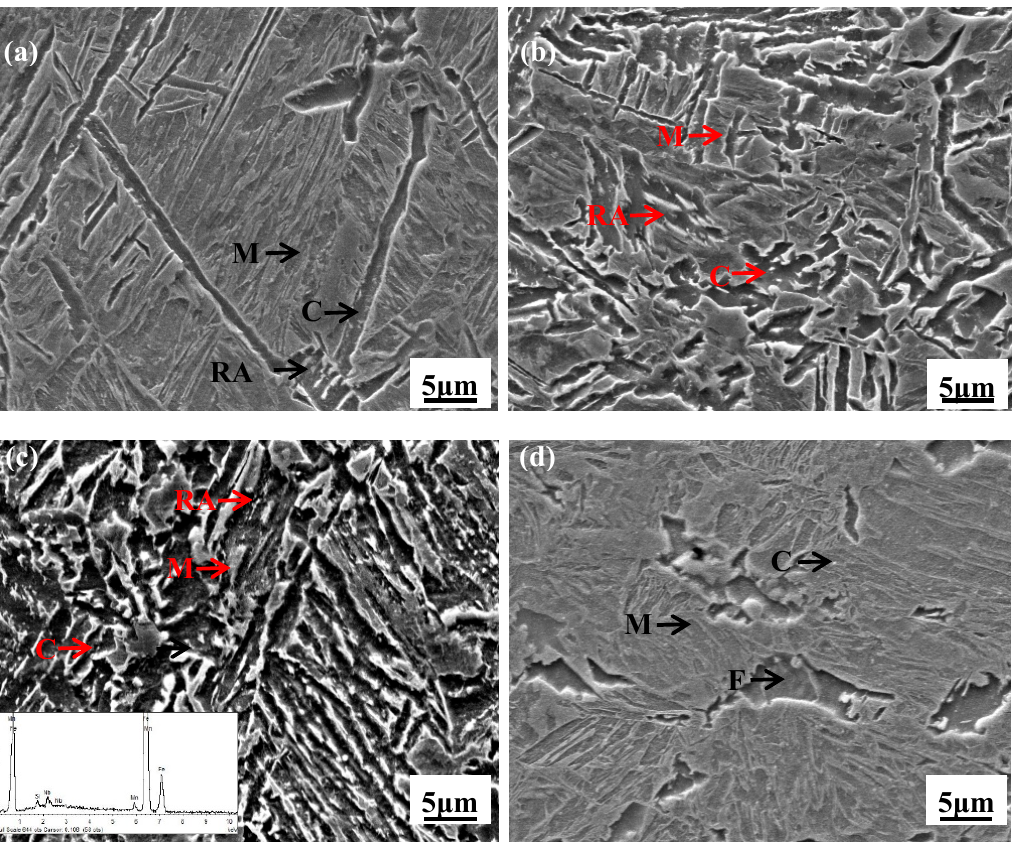
Figure 4. SEM micrographs of the test steel with different technology; ( a ) The partitioning time is 10 s with Q&P processing; ( b ) The partitioning time is 60 s with Q&P processing; ( c ) The partitioning time is 120 s with Q&P processing and carbide energy spectrum; ( d ) The relaxation time is 6 s with DP processing. M is martensite, F is ferrite, RA is retained austenite and C is carbide.